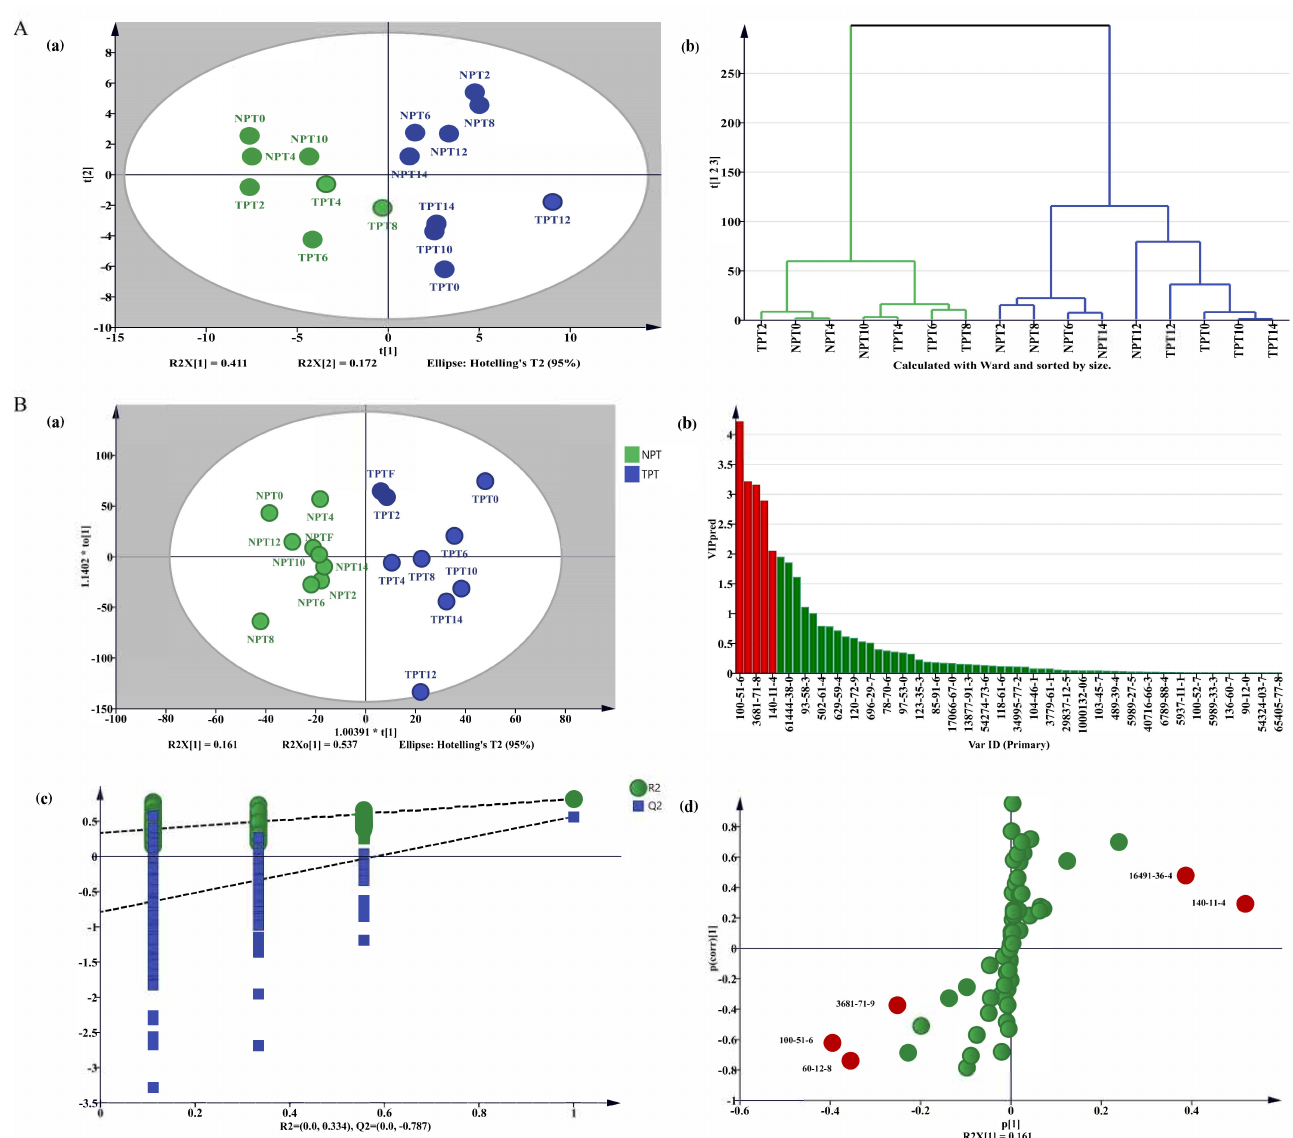
Figure 7. Comparative analysis of different volatile components of jasmine tea. ( A ) Comparison and analysis of volatile components in jasmine tea during the different scenting processes: ( a ) PCA score chart; ( b ) HCA chart. ( B ) Comparative analysis of volatile components of TPT and NPT: ( a ) OPLS-DA score plot; ( b ) VIP plot. ( c ) permutation tests plot. ( d ) S-plot. The color in ( B )/( b ) and ( d ) means that differential volatile component is marker in green color; those significant differential volatile components with a VIP > 1 and FC > 1.5 or <0.67 ( p < 0.05) marker in red